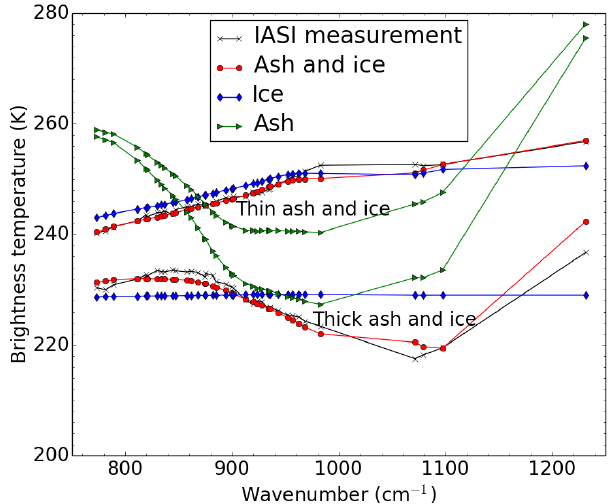
Figure 6. The brightness temperature for the pixels identified as ash in the right panels of Figs. 1 and 2, and marked as thick and thin ash and ice examples in the left panel of Fig. 4 and in Table 1. The brightness temperature is shown only for points which are used to calculate the RMSD, Eq. (1). The various colours refers to the three cases described in Sect. 4.2. Note that the lines connecting the points are drawn just for visualisation and do not represent the actual spectral behaviour between the data